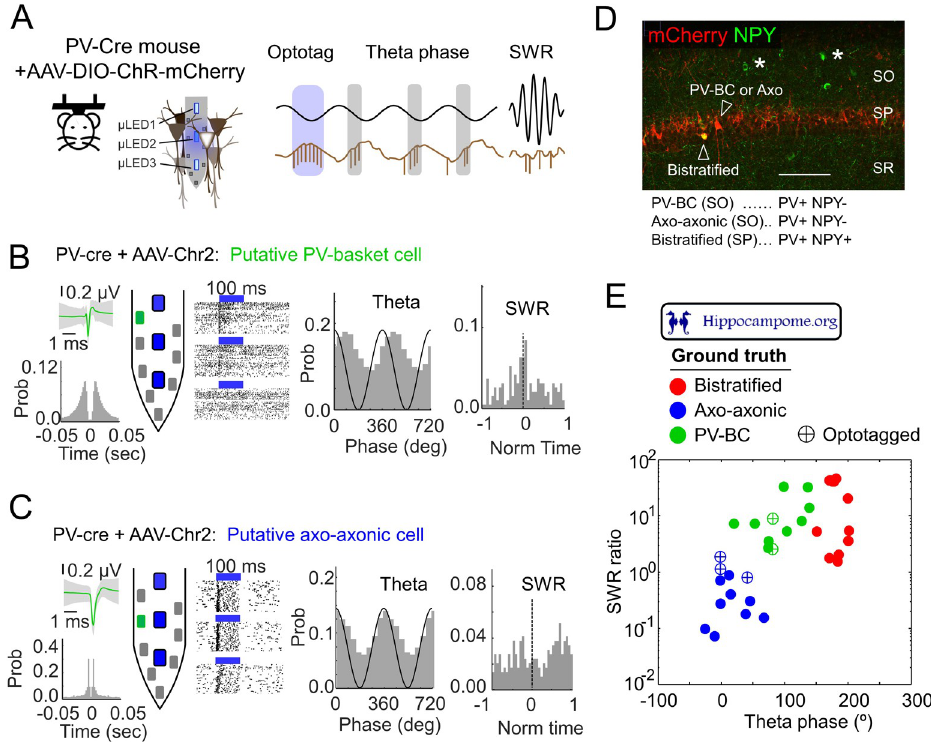
Fig 6. Using Hippocampome.org to promote knowledge-based phenotyping of optotagged cells in vivo. (A) PV- cre head-fixed mouse injected with AAV-DIO-ChR2-mCherry to couple optogenetic tagging with high-density recording. ( B) Example of one optotagged putative PV-BC. The extracellular action potential waveform and autocorrelogram of the unit is shown at left. The channel corresponding to the maximal amplitude action potential is shown green in the probe drawing (i.e., channel closest to the unit). Responses of the unit to several trials of optical stimulation is depicted next to the probe for each of the 3 LEDs, followed by the unit theta phase-locked firing and responses during SWR. ( C) Example of one putative axo-axonic cell. Same as in B. ( D) Histological confirmation of the subpopulations of CA1 GABAergic cells targeted in the PV-cre mouse. Different PV+ cell types are indicated by arrowheads. Asterisks indicate some NPY+ cells. ( E) The firing dynamics of n = 5 optotagged units during theta and ripples are evaluated and confronted against ground truth from the Hippocampome.org phase encoding. The location of optotagged cells with respect to cell-type specific clusters is evaluated with k-means: putative PV-BC were significantly closer to the PV-BC cluster ( p = 0.0003); putative axo-axonic cells were significantly closer to the axo- axonic cluster ( p = 0.0004). The underlying data can be found in S1 Data. LED, light-emitting diode; NPY, neuropeptide-y; PV, parvalbumin; PV-BC, PV basket cell; SO, stratum oriens; SP, stratum pyramidale; SR, stratum radiatum; SWR, sharp-wave